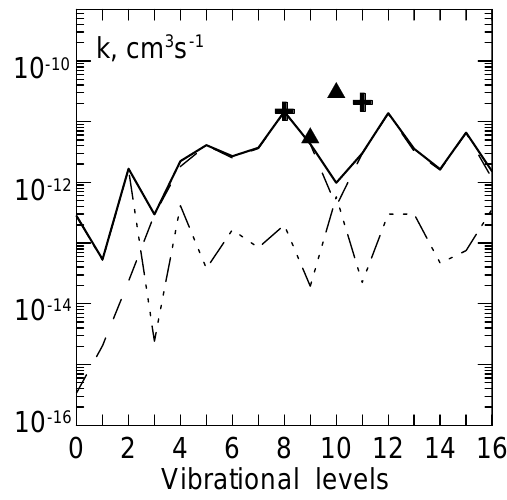
Fig. 2. The calculated quenching rate coefficients of O 2 ( c 1 6 − u , v =0-16)+O 2 (solid line) are compared with experimental data by Copeland et al. (1996) and Wouters et al. (2002) (triangles at T =300K, crosses at T =245K). Dashed line and dash and three dot- ted line are the contributions of intramolecular and intermolecular electron energy transfer processes, respectively.